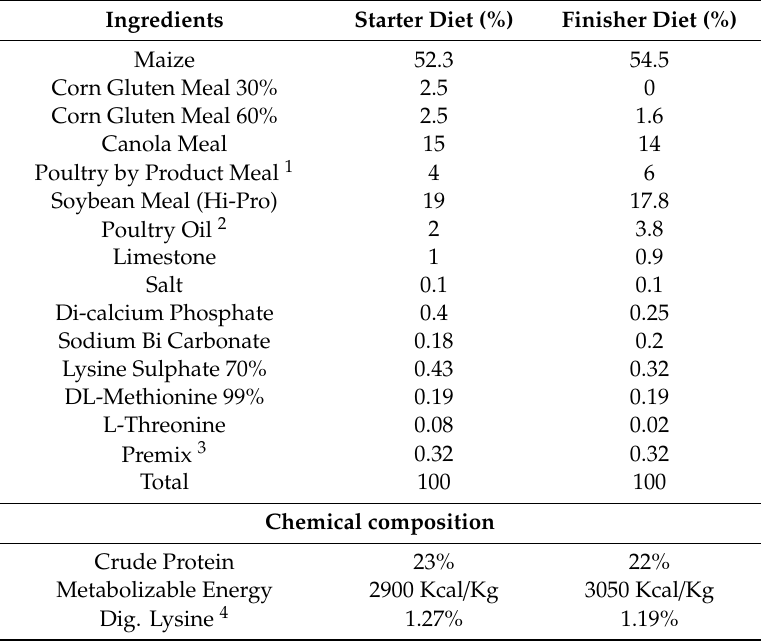
Table 1. Diet formulation and chemical